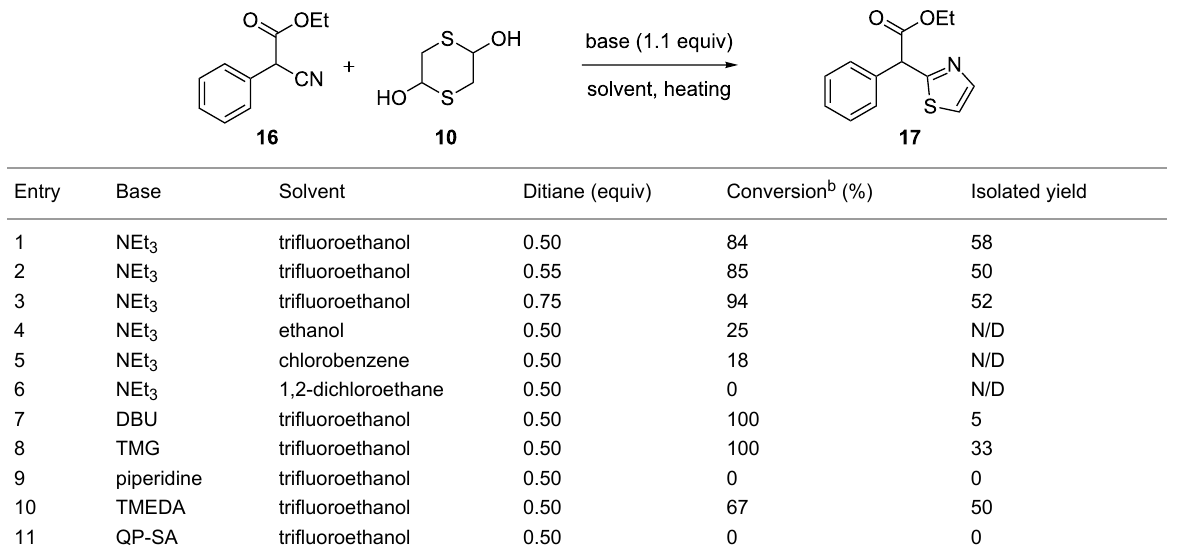
Table 1: Scoping experiments using ethyl phenylcyanoacetate ( 16 ) with different solvents and bases.